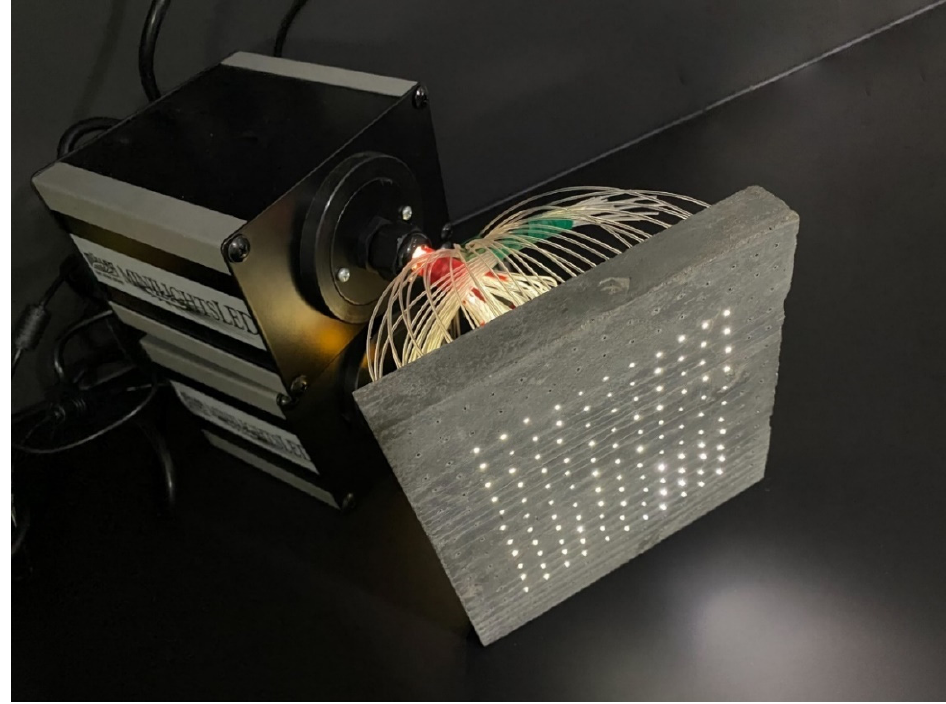
Figure 22. Slab with optical fibers connected to an artificial light source.